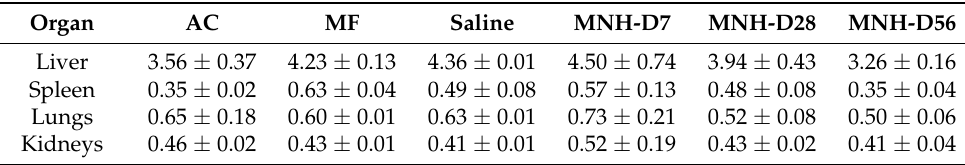
Table 1. Mean ( ± SD) relative weight (%) of organs on the day of euthanasia for the different experimental groups.